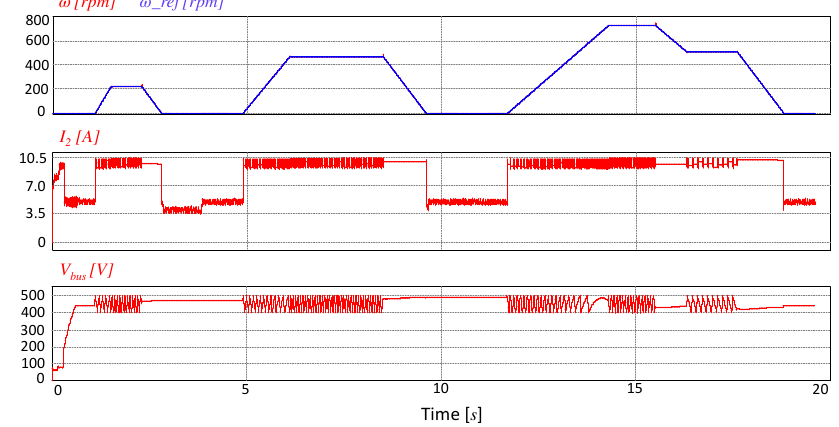
Figure 17. Behavior of the state variables through the ECE-15 cycle. The speed of the motor following the ECE-15 cycle; the current through inductor L 2 , I 2 and the voltage in the capacitor C bus , V bus